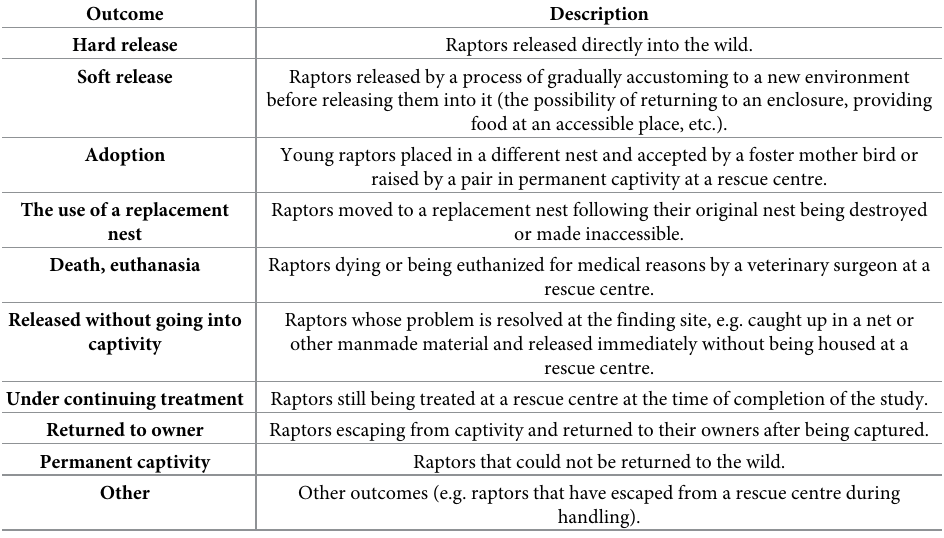
Table 2. Outcomes for raptors at rescue centres in the Czech